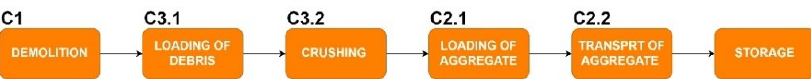
Figure 3. End-of-life process included in the analysis.